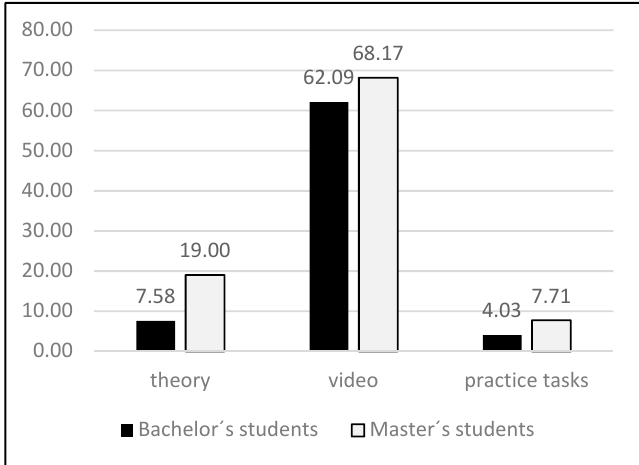
Figure 7. Average visit in options under ‘Cognitive constructivism’.